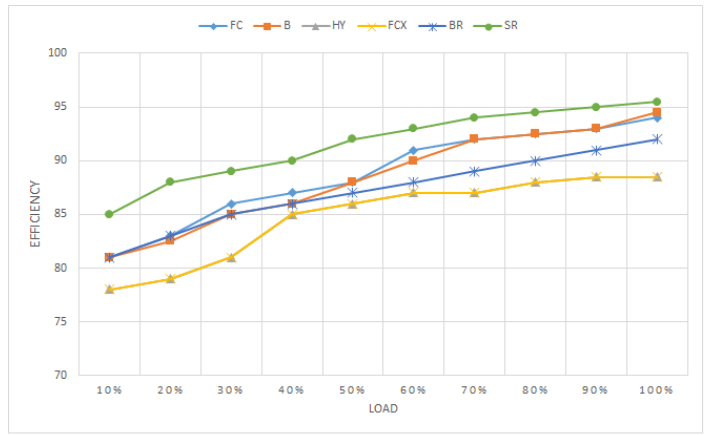
Figure 26. Efficiency curve for different modes of operation.